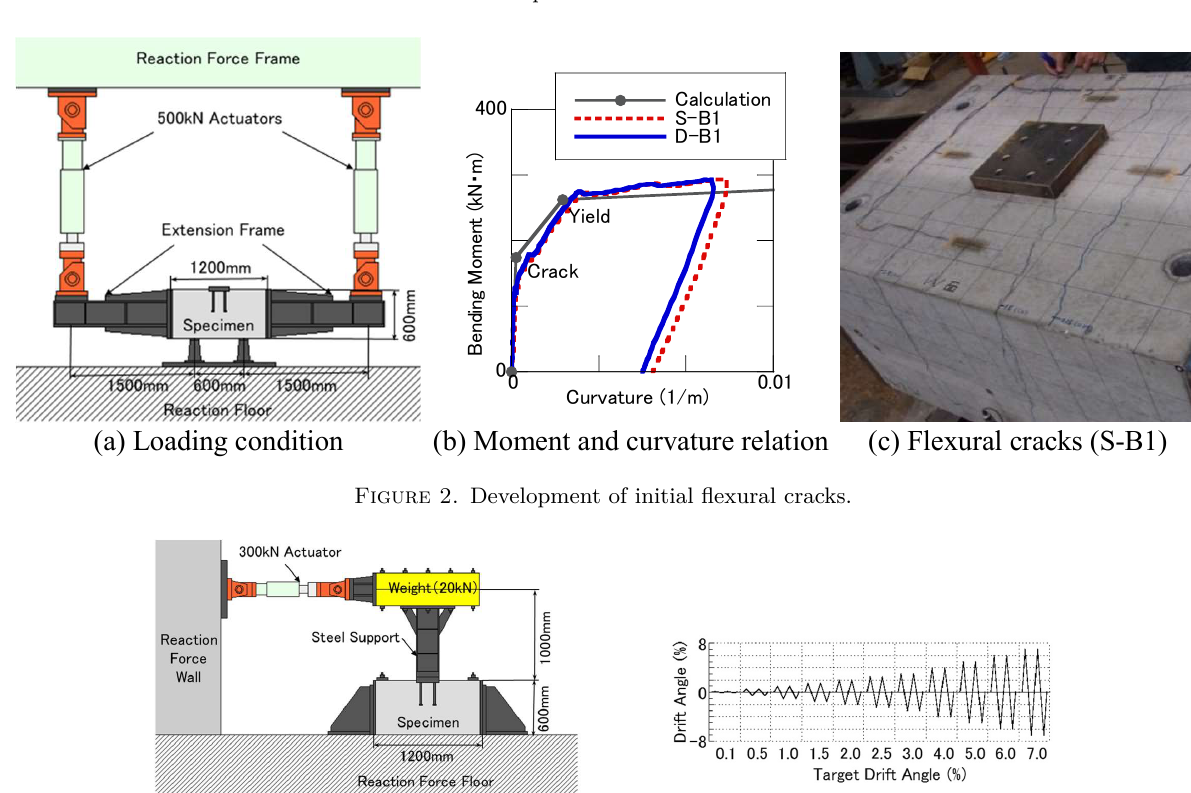
Table 2. Development of initial flexural cracks.